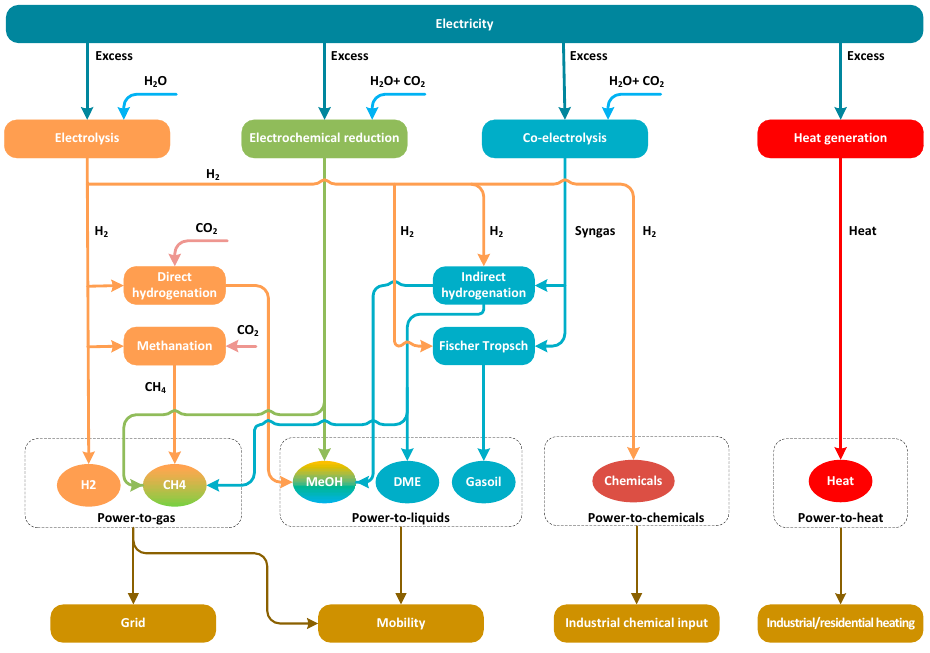
Figure 1. Schematic diagram of PtX conversion routes. DME = dimethyl ether. MeOH = methanol.